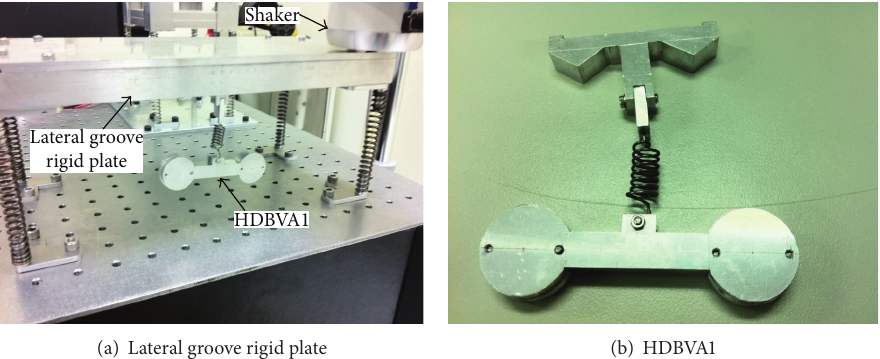
Figure 4: Experimental set up of HDBVA1 on lateral groove rigid